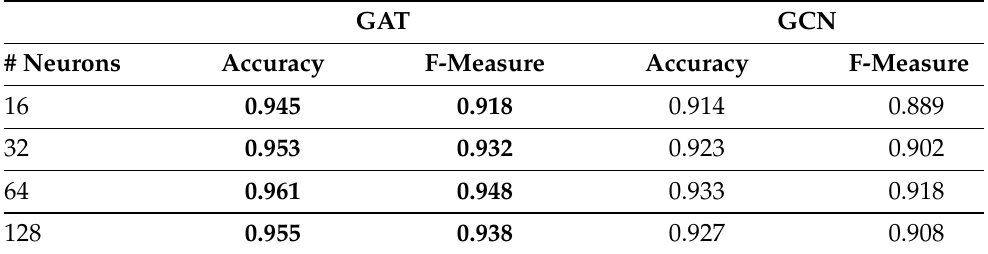
Table 5. Classification results using node features generated with Node2Vec